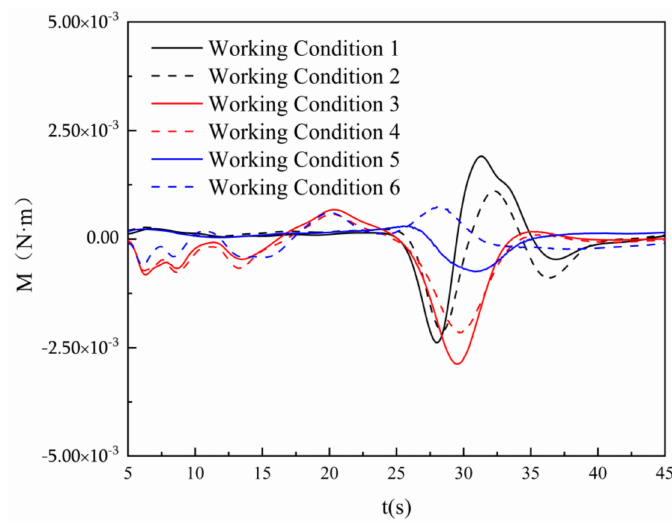
Figure 12. Riser torque history curve for different working